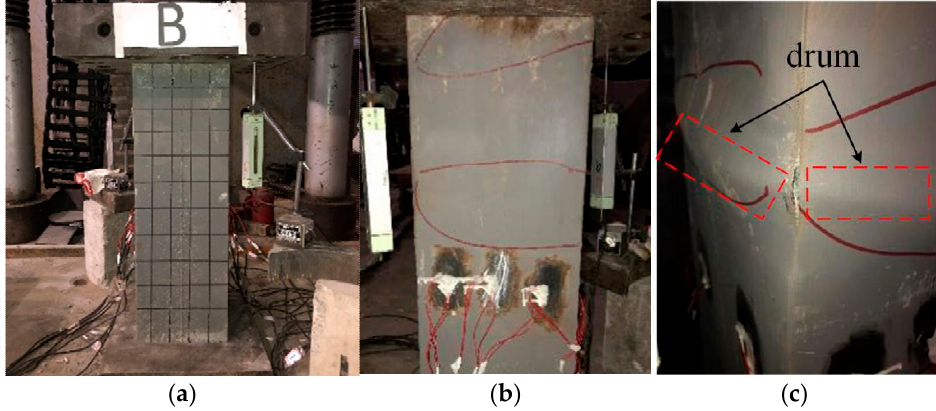
Figure 2. Concrete-filled steel tubular specimen. ( a ) Before test loading. ( b ) Peak bearing capacity. ( c ) After test loading.